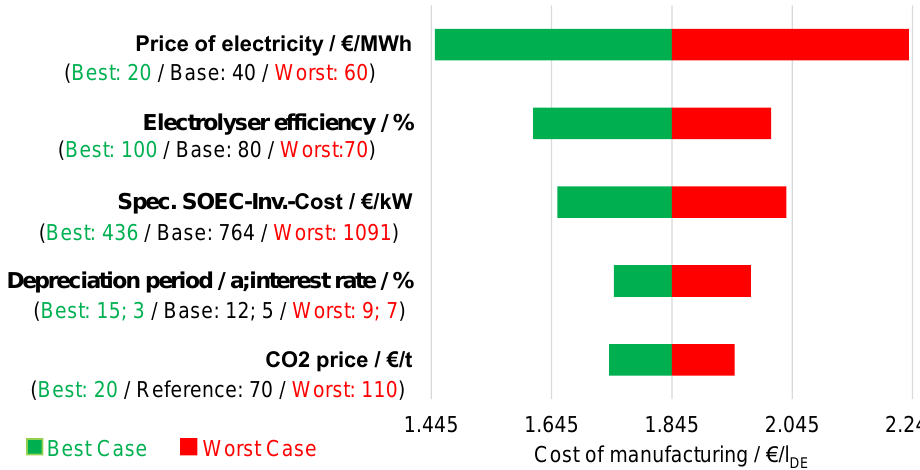
Figure 21. Tornado diagram of the sensitivity analysis of product generation costs.